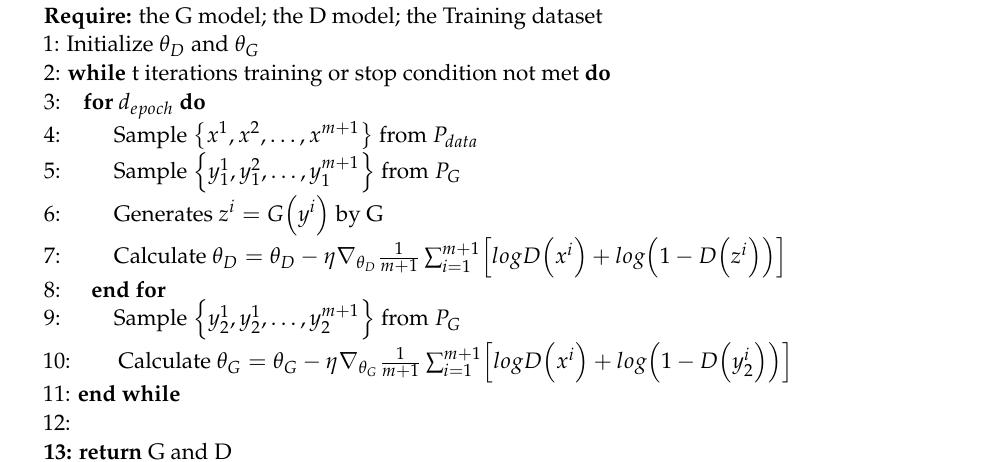
Algorithm 1 The GAN model training